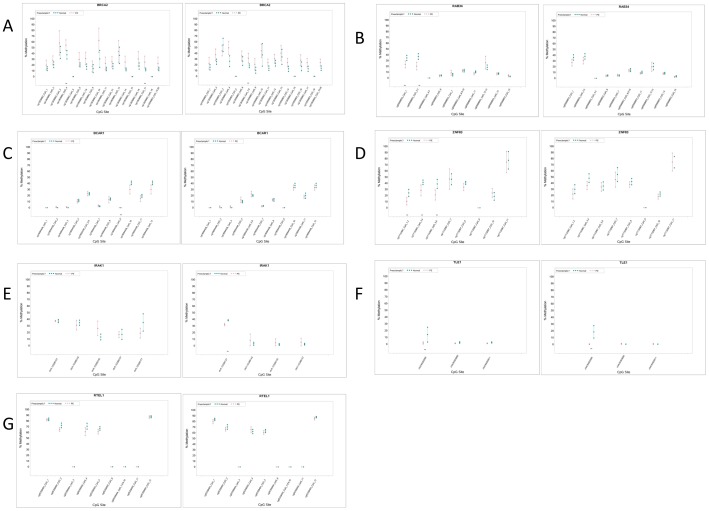
Targeted Analysis of Differentially Methylated Loci in Preeclampsia.Locus-specific analysis of CpG methylation in normal controls and preeclampsia samples was carried out by Sequenom Epityper (TLE1, IRAK1) (n = 24 controls and n = 24 PE samples) or high-throughput bisufite sequencing (n = 12 controls and n = 12 PE). Samples from pregnancies involving female (left panel) and male (right panel) fetuses were analyzed separately. Statistically significant differences in% methylation between samples are marked with **. Genomic coordinates corresponding to values on the x-axis can be found in Table S6A in File S1.